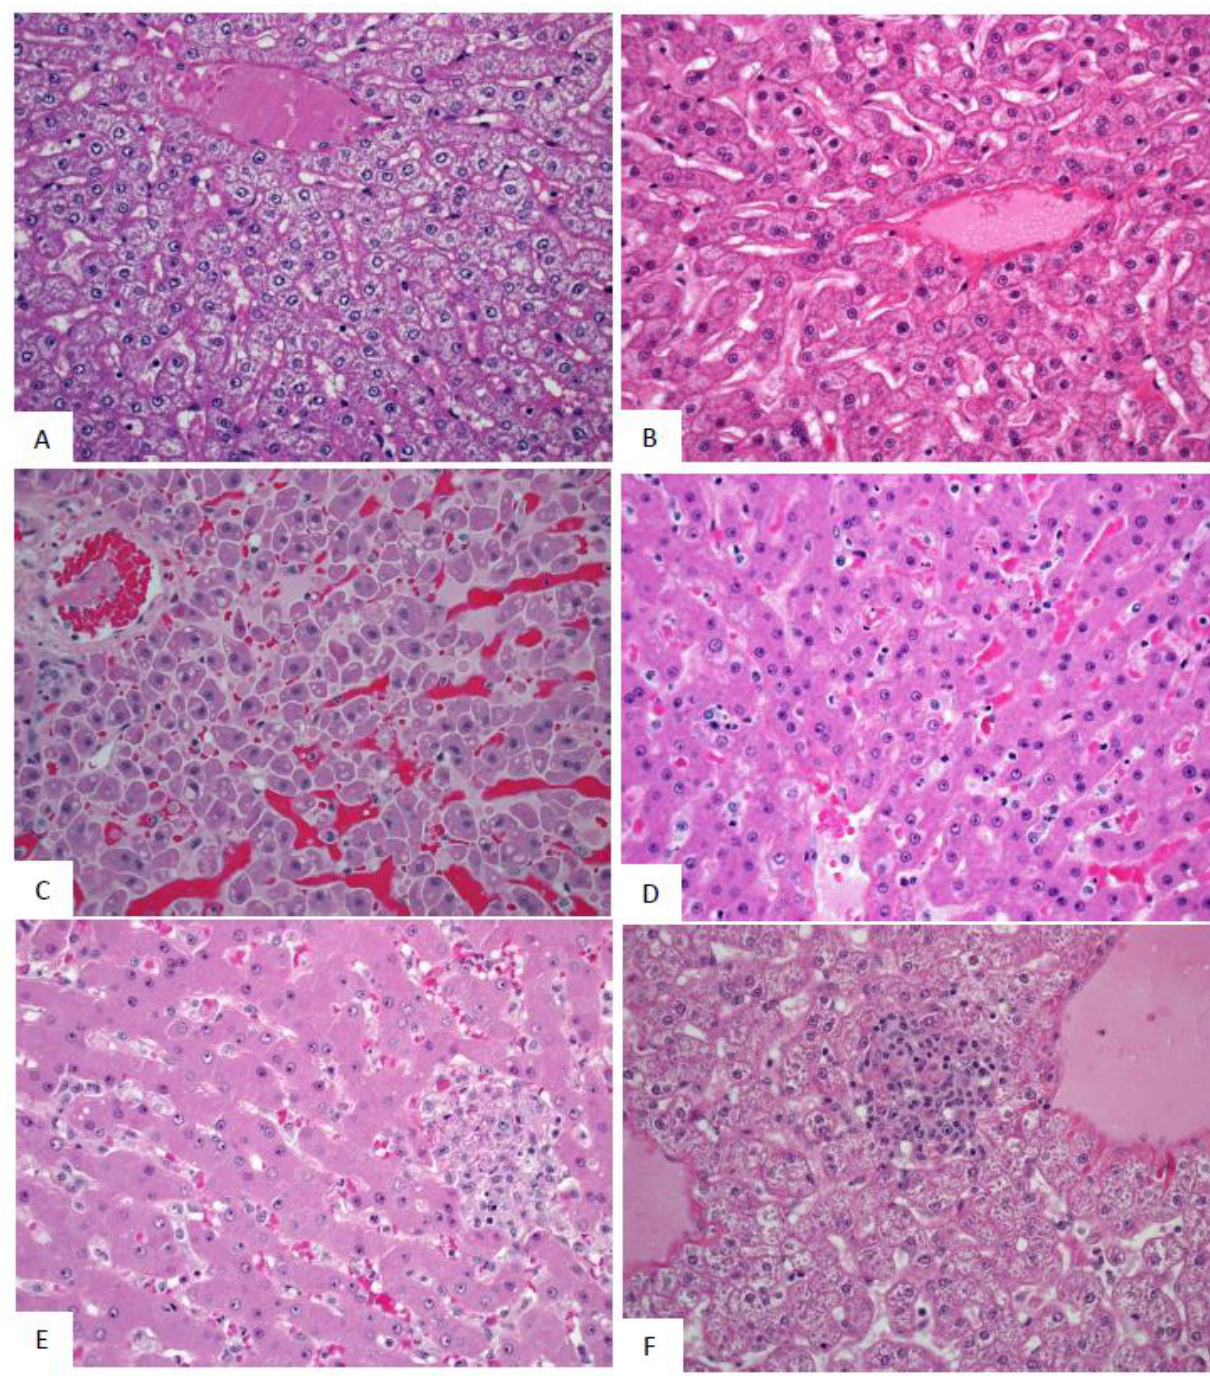
Figure 10. Representative images of microscopic findings: Liver. Microscopic findings at necropsy in cynomolgus macaques intramuscularly exposed to SUDV Gulu. Liver. ( A ) Day 21 control, No. 478. Essentially normal tissue. 40x; ( B ) Day 2 PE scheduled euthanasia, No. 491. Essentially normal tissue. 40x; ( C ) Day 5 PE scheduled euthanasia, No. 493. There is single cell hepatocellular degeneration, necrosis and vacuolation. 40x; ( D ) Day 7 PE, No. 477. There is rare necrosis of individual hepatocytes with inflammation and sinusoidal fibrin. 40x. ( E ) Day 9 PE scheduled euthanasia, No. 476. There is single cell hepatocellular necrosis with inflammation and fibrin. 40x; ( F ) Day 21 PE SUDV survivor, No. 487. There is multifocal mononuclear cell inflammation. 40x.